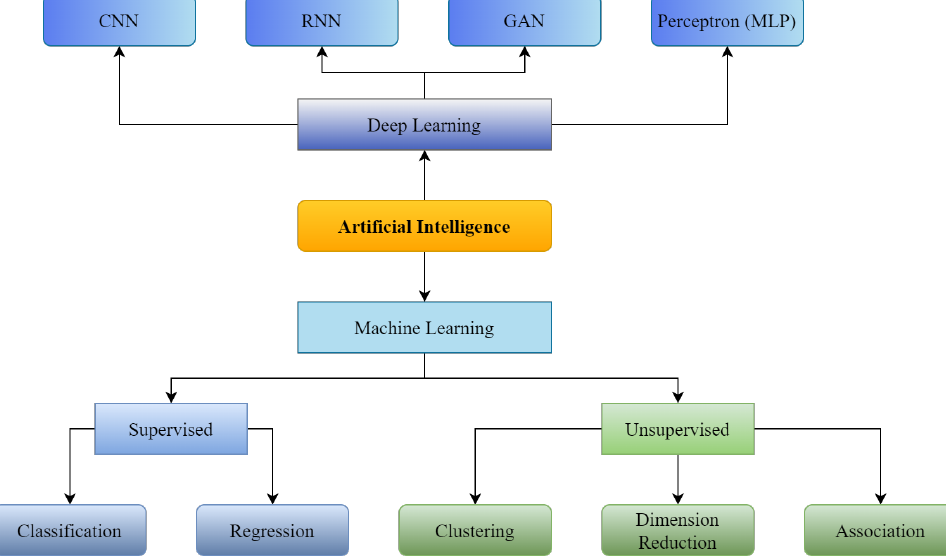
Figure 1. Supervised and Unsupervised machine learning with Convolutional Neural Network (CNN), Recurrent Neural Neural Network (RNN), Generative Adversarial Network (GAN) as branches of Deep